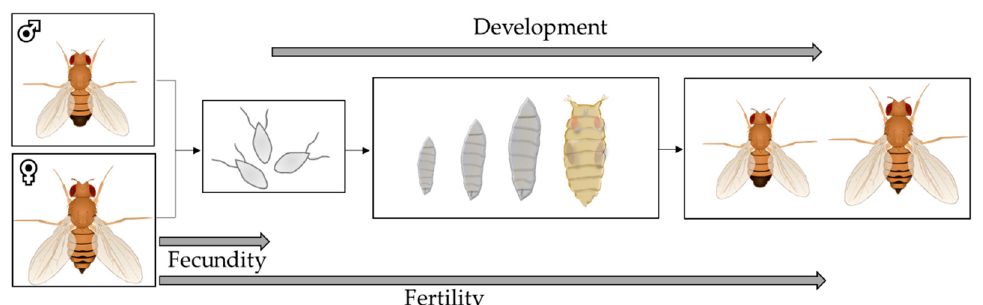
Figure 10. Determination of reproductive parameters in Drosophila melanogaster . After prefeeding males, females or both, single females, a couple or a group of flies are combined for mating. Subse- quently, the reproductive performance of the female flies is examined. To determine the fecundity of flies, the eggs laid per time interval are counted. To assess fertility, the number of living offspring (larvae, pupae or adults) that develop from the laid eggs is calculated as a percentage value. Concerning the analysis of the development of the F1 generation, which considers the process from the laid egg through the individual developmental stages to the adult fly, parameters such as the development time or the sex ratio of the offspring are determined (modified from [94]).